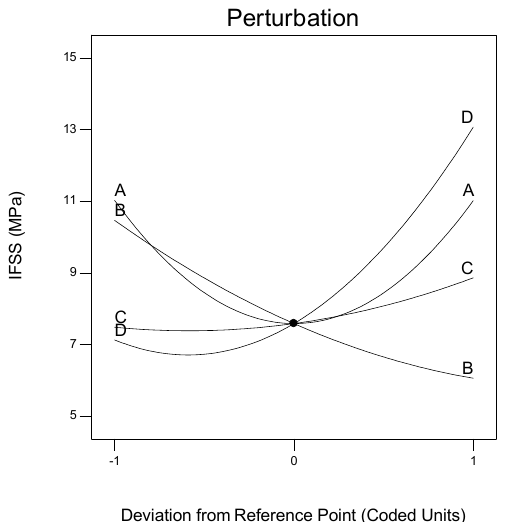
Figure 9. Perturbation plot showing the influence of all factors on IFSS at the midpoint of the design space.